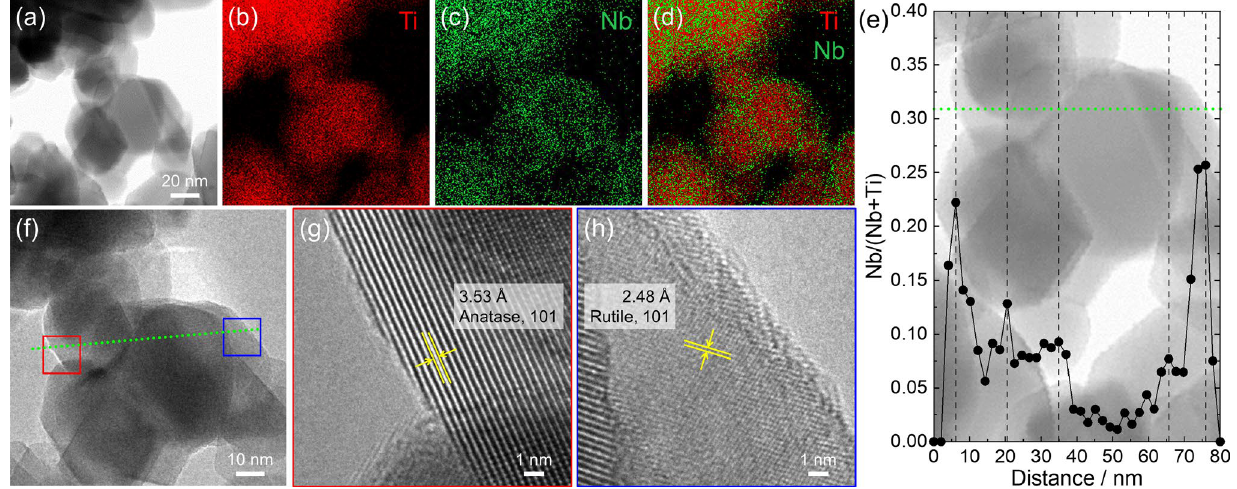
Figure 5. ( a ) STEM image, ( b )–( d ) STEM-EDS mapping images, and ( e ) STEM-EDS line scanned profile of NTO-5–800. The dot line in ( e ) represents the scan points at the edge of the particles. ( f )–( h ) TEM images of NTO-5–800. In ( f ), red and blue squares are magnified area of ( g ) and ( h ) and green dots are STEM-EDS line scanned points shown in ( e